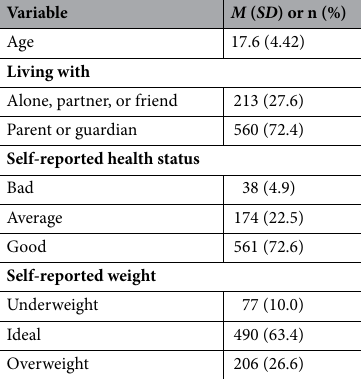
Table 1. Background factors of the students (n =